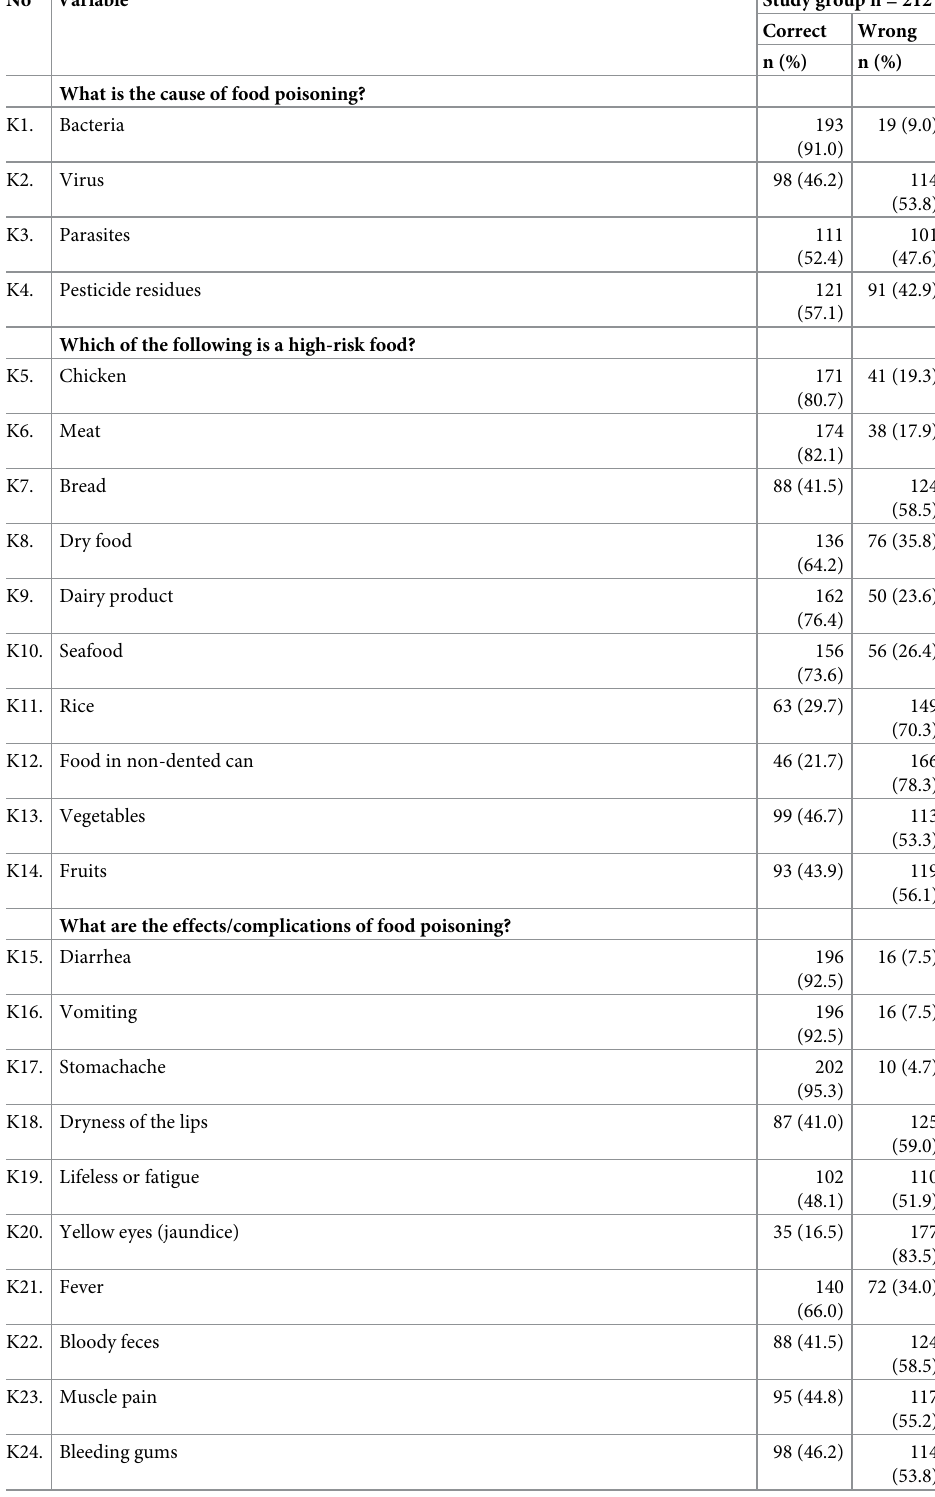
Table 6. Descriptive of knowledge statements of food poisoning among the respondents (N =